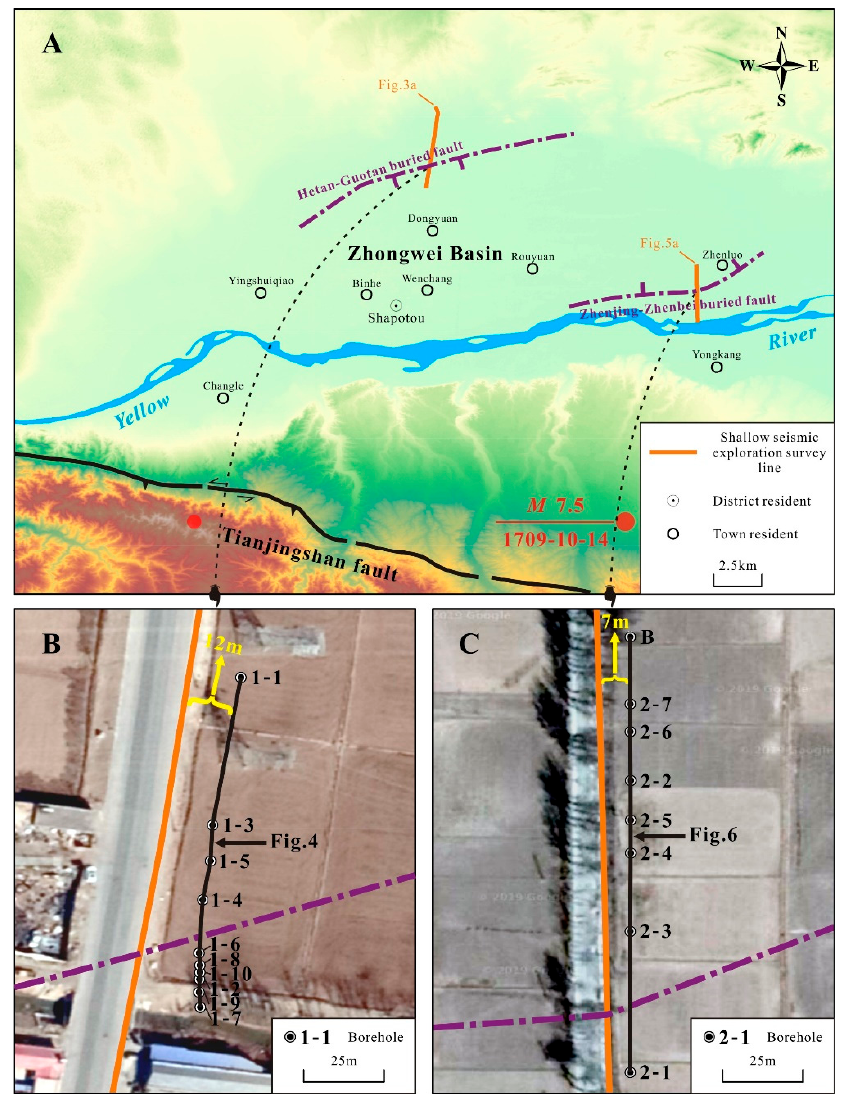
Figure 2. The location of shallow seismic exploration and composite drilling section exploration. ( A ) The distribution of buried faults and shallow seismic survey lines in Zhongwei Basin. The epicenter of the 1709 M 7.5 earthquake on the Tianjingshan Fault is highlighted. ( B ) The location map of boreholes and composite drilling section exploration (Black bold line) in Xietan Village. ( C ) The location map of boreholes and composite drilling section exploration (Black bold line) in Lizui Village.